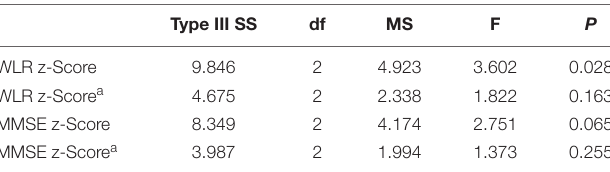
TABLE 7 | Results of general linear model analyses for assessing the relationship between serum UA strata and cognitive performance in non-demented older